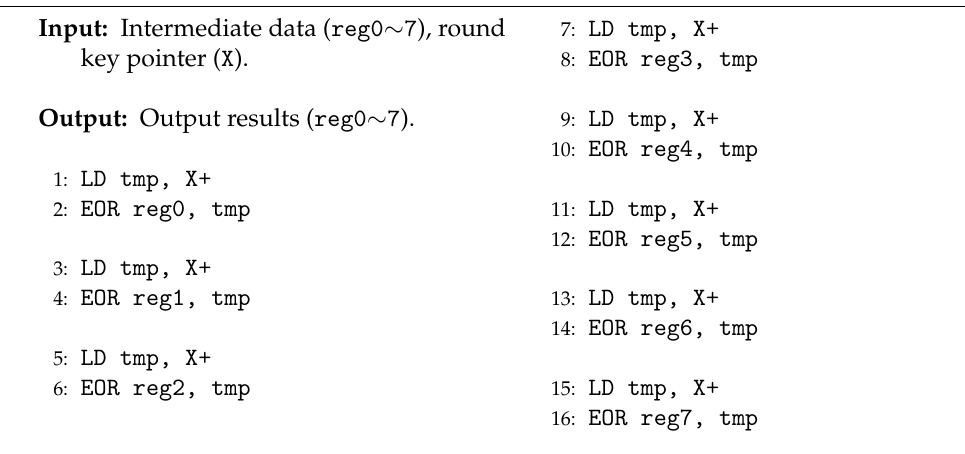
Algorithm 1: Add-round-key operation in assembly